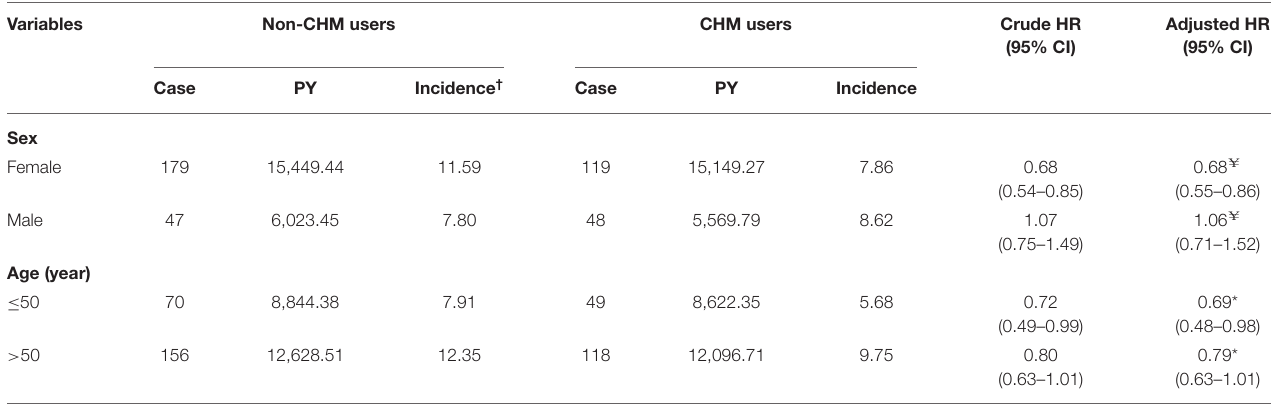
TABLE 3 | Incidence and risk of HL among RA patients with and without CHM use by sex and age.